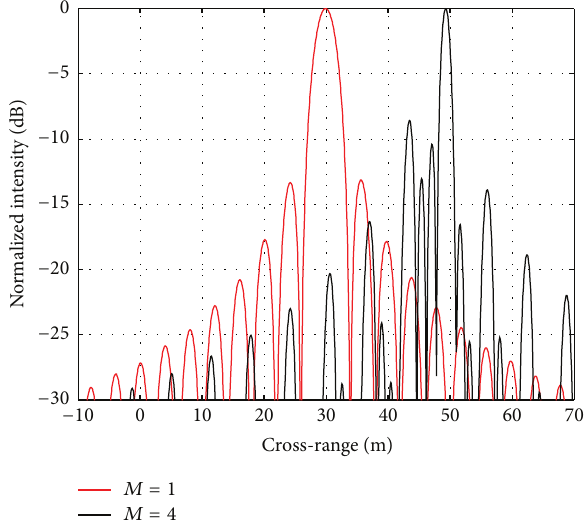
Figure 7: ISAR profiles obtained without applying the time selec- tion.